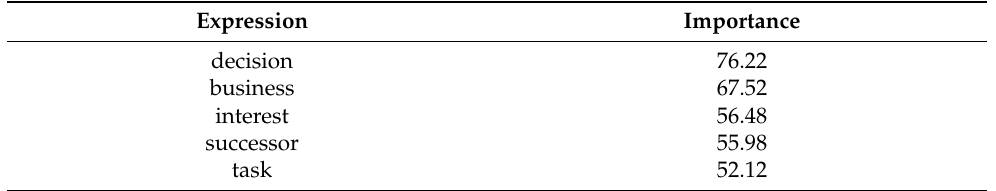
Table 5. Weight of criteria: successor education.